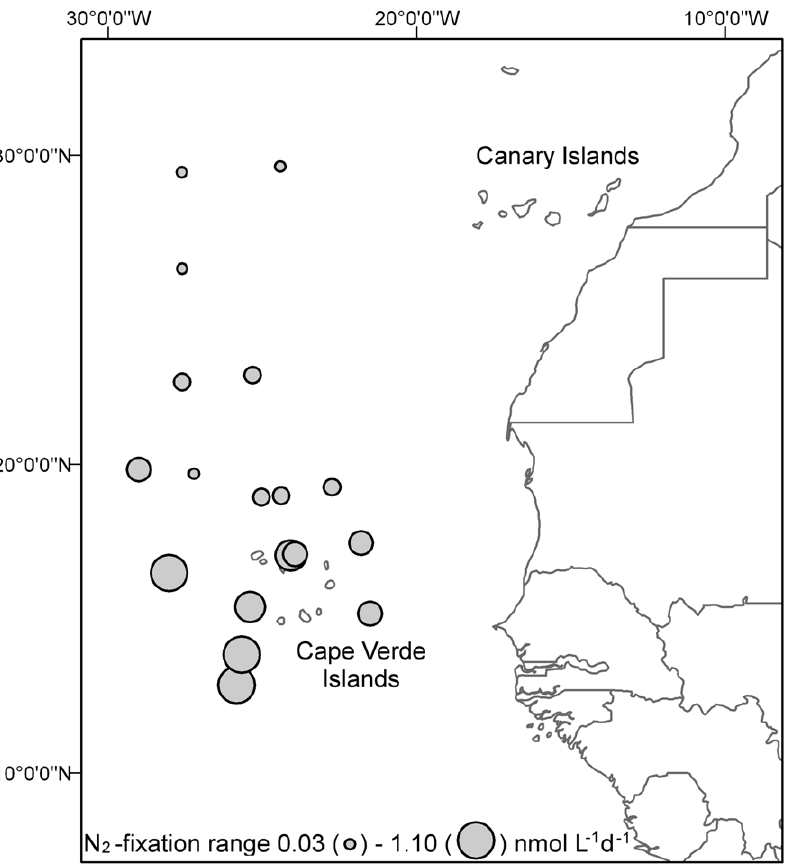
Figure 3. Bubble plot of the average N 2 fixation rates (nmol L 2 1 d 2 1 ) based on 3 to 4 replicates.